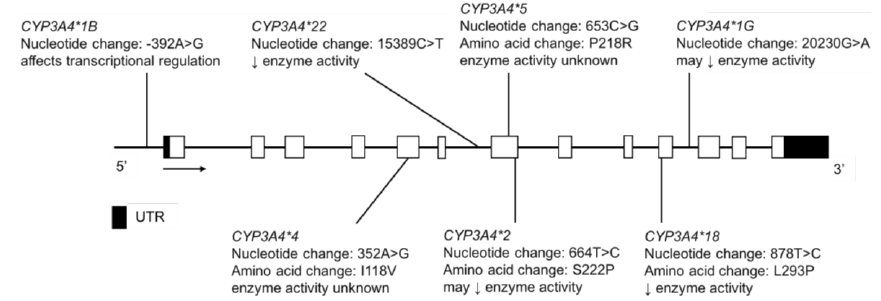
Figure 11. The human CYP3A4 gene and SNVs tested for in the CSKT and Amerindian populations. Novel non-coding variants are not shown. Open boxes represent exons, lines represent introns and shaded boxes represent UTR. J. Pers. Med. 2018 , 8 , x FOR PEER REVIEW